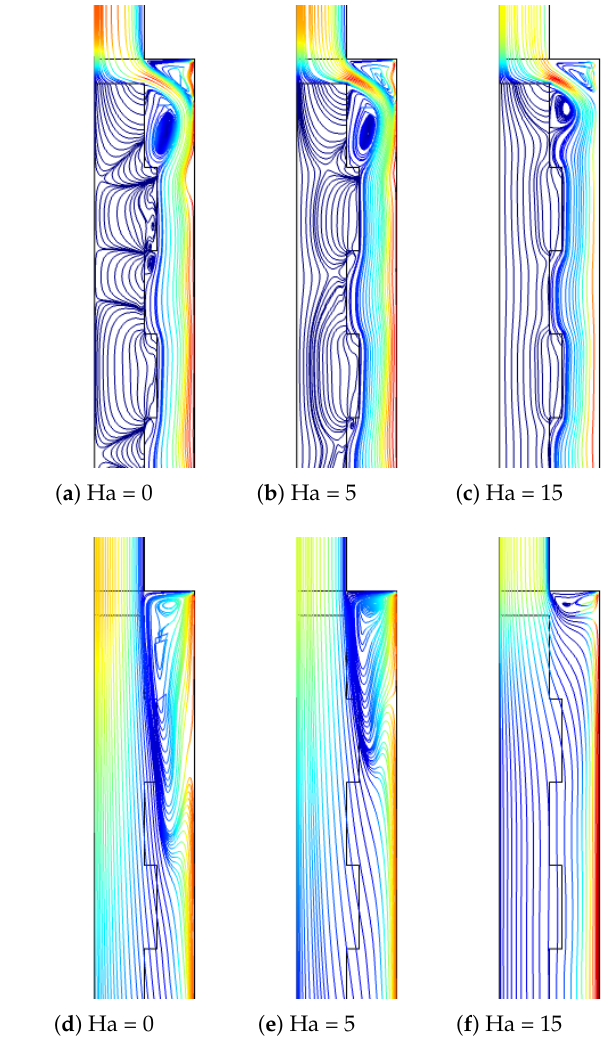
Figure 9. Impacts of MaF strength on the FP distributions at two different PL permeability (( a – c ), Da = 10 − 5 ), (( d – f ), Da = 10 − 2 ) (Re = 250, Rew = 1000, ax = 0.25 ap, N = 4). Comparisons of average Nu and pressure coefficients for different Da at stationary and rotating wall cases are shown in Figure 11 for fixed values of (Re = 250, Ha = 7.5, ax = 0.25 ap, N = 4). Lower permeability configurations with rotating surfaces lead to higher HT and pressure coefficients. The impacts of rotation of the variation of Cp reduces with permeability. The impacts of rotation on the reduction of average Nu with higher permeability becomes less. The amount of reduction in the average Nu between the lowest and highest Da cases becomes 14% and 52.7% at Rew = 2000 and Rew =